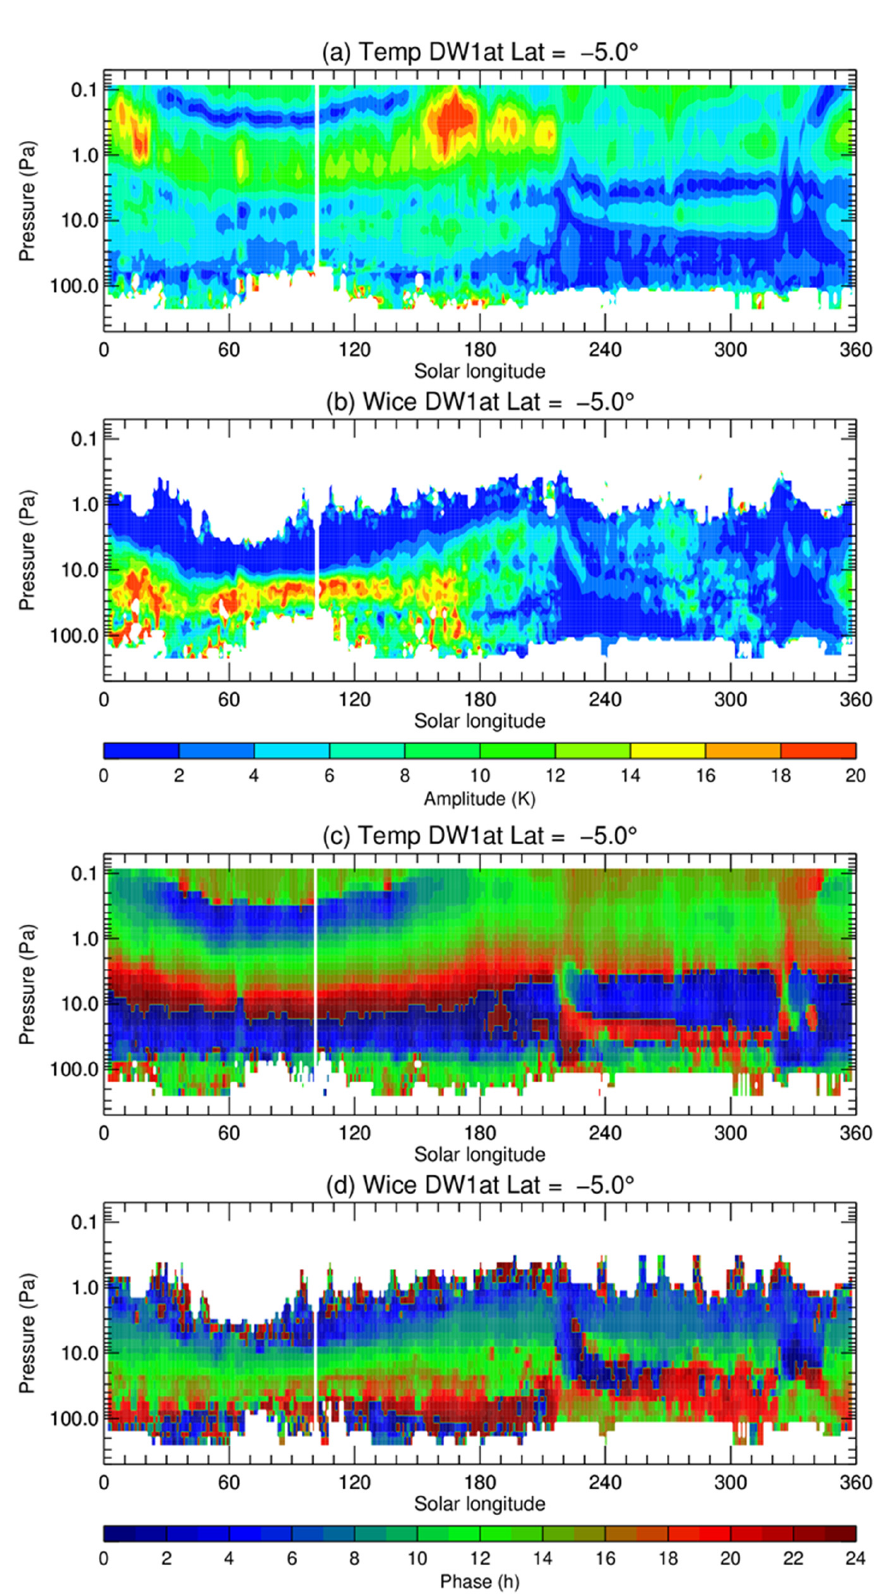
Figure 8. Seasonal variations of the temperature ( a , c ) and water ice ( b , d ) DW1 amplitude ( a , b ) and phase ( c , d ) at 5°S. Note that the water opacity value has been multiplied by 10 4 .